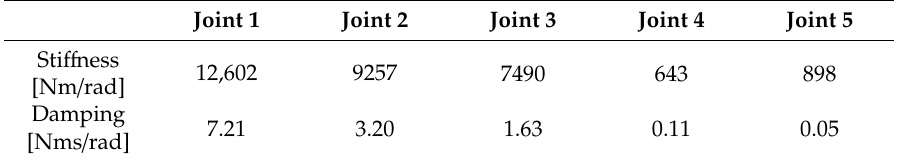
Table 2. Robot sti ff ness and damping properties obtained with the 1-degree-of-freedom (DOF) model.